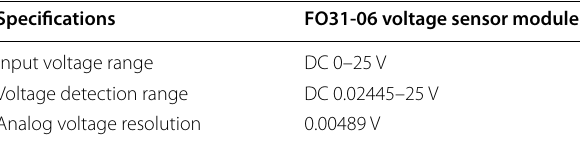
Table 2 Specifications of the F031-06 voltage sensor mod-